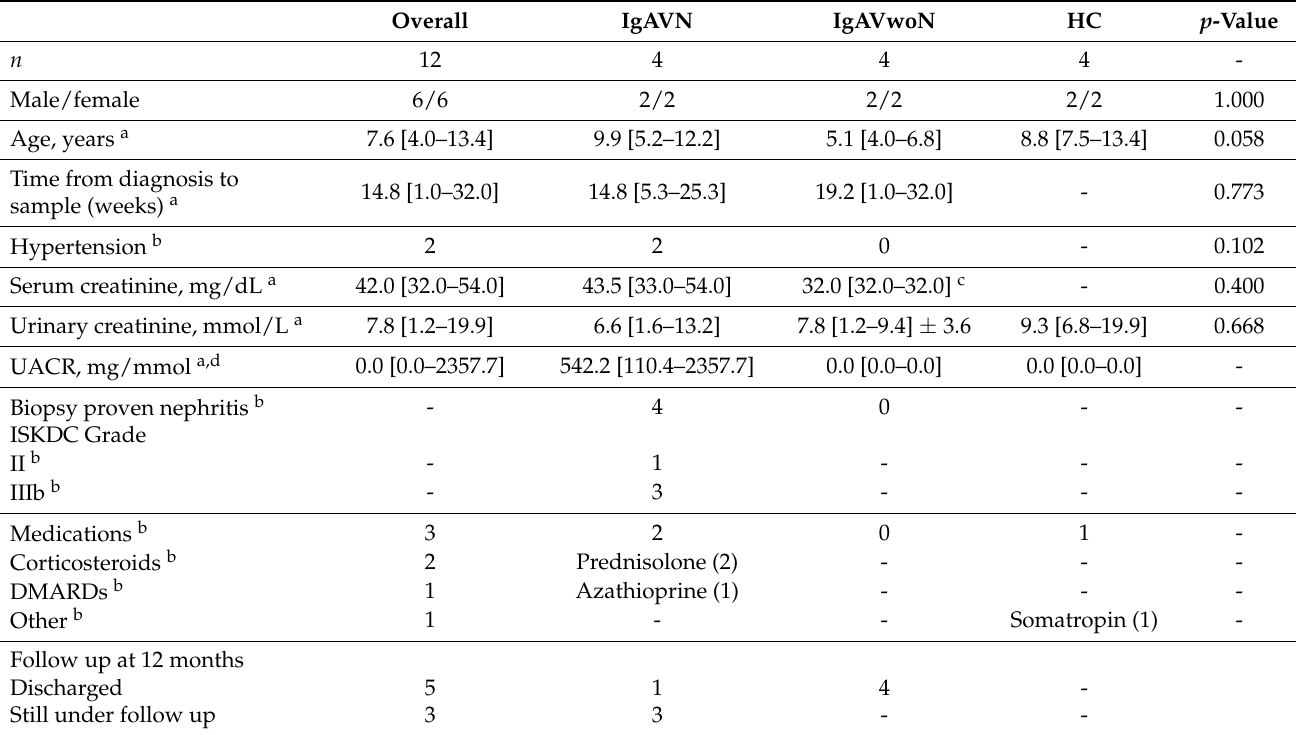
Table 1. Patients characteristics at